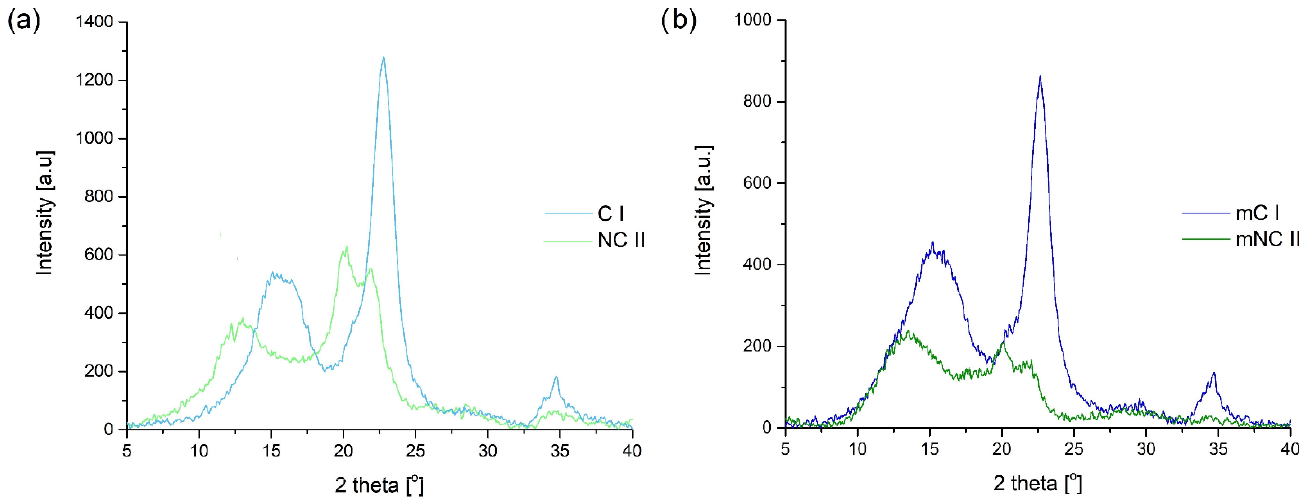
Figure 4. WAXS patterns for native and alkali-treated cellulose: ( a ) before PEG modification; ( b ) after PEG modification.